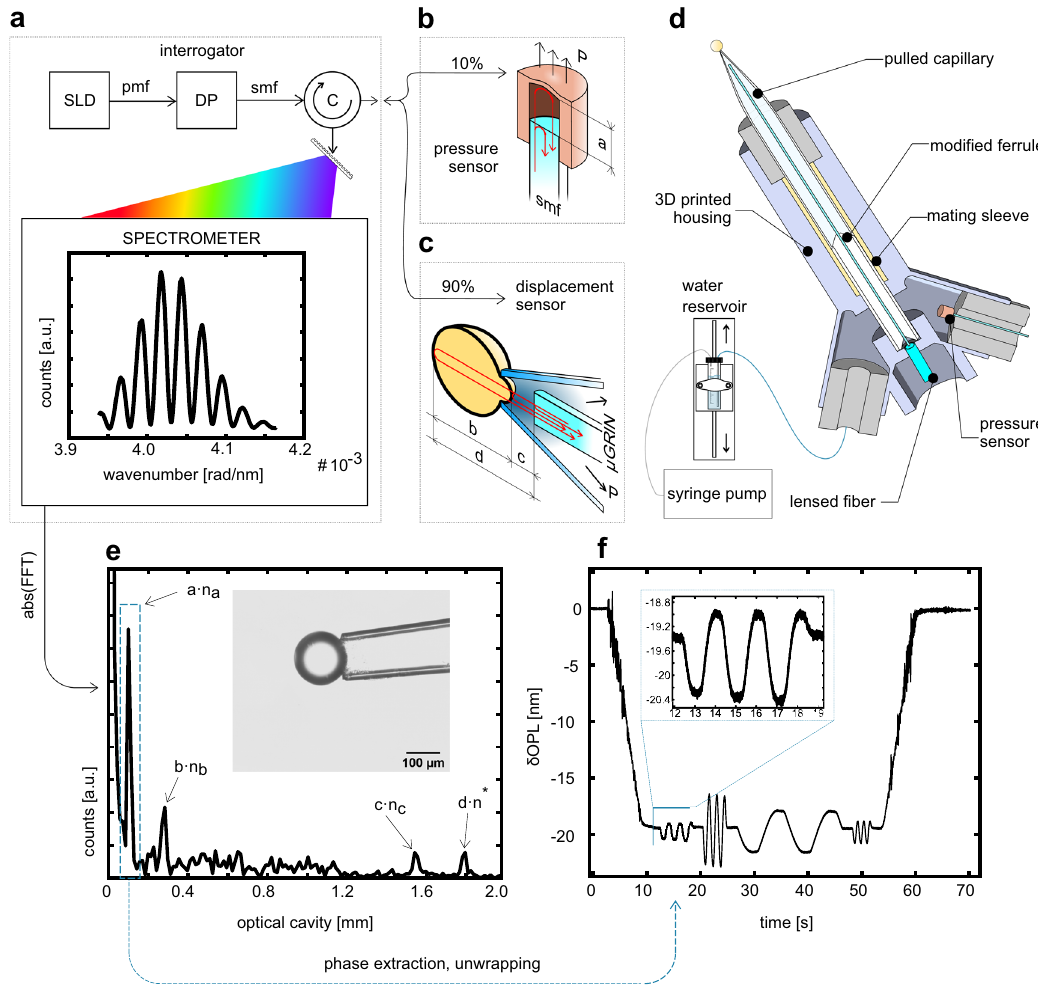
Fig. 1 Schematics of the optical readout setup and data analysis process. a The optical interrogator (Deltasens) is comprised of a superluminescent diode (SLD) connected to a depolarizer (DP) via a Panda fi ber (pmf). The DP is then connected to a circulator (C) with a single mode fi ber (smf), which reroutes the signal to the spectrometer and, via a 90/10 optical fi ber splitter, to the sensors. b , c These are shown schematically (not to scale) to highlight the Fresnel re fl ections occurring at RI discontinuities (red arrows), with the resulting optical cavities (dimensions a to d). d Schematic cross-section of the probe where its components and the connection to the water reservoir and syringe pump are shown. During an experiment, a pressure variation at the probe nozzle can be operated either by changing the height of the water reservoir or by operating the syringe pump. e Fourier transform of an interference signal taken after capturing a 160 µ m polystyrene bead (as shown in inset). The n subscripts refer to the RIs of the media between the interfaces, referring to the dimensioning shown in the sensors highlight ( n * is a weighted average of n b and n c ). Each peak contains phase information. By selectively tracking its variation over time, it is possible to obtain optical path length variation, δ OPL, versus time plots. f Example of the un fi ltered pressure sensor response to a DMA-like test. Note the sub-nanometer resolution, highlighted in the